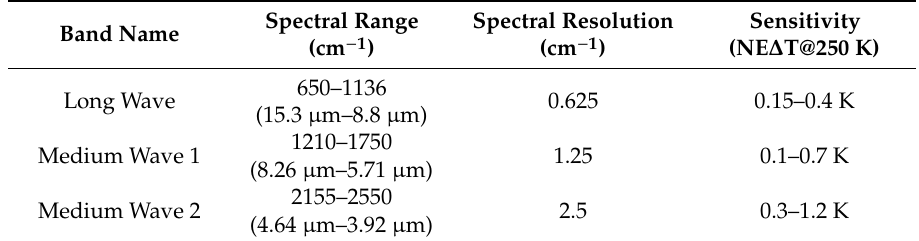
Table 1. Fengyun-3D Hyperspectral Infrared Radiation Atmospheric Sounding (FY-3D/HIRAS) channel spectral characteristic parameters.